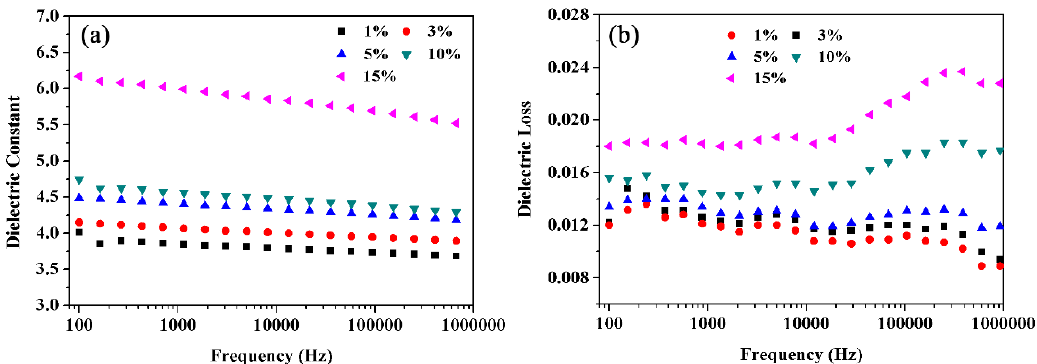
Figure 8. Dielectric constant ( a ) and dieledctric loss ( b ) of PEN composites with 1, 3, 5, 10 and 15 wt % of BT@ZnPc-GO-2.